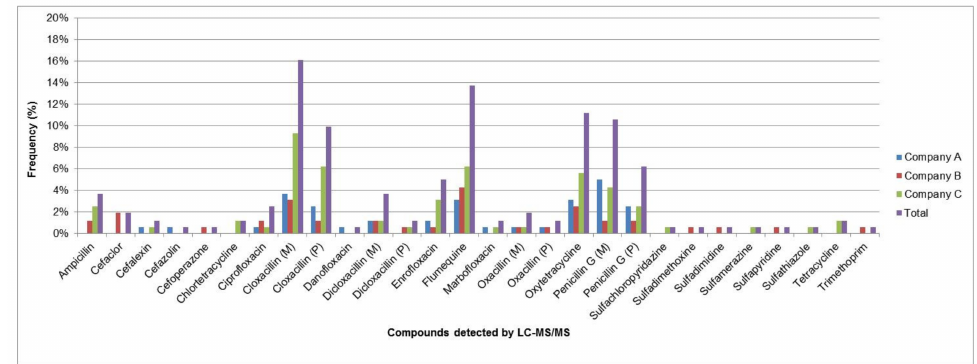
Figure 3. Distribution and frequency of antibiotic residues in